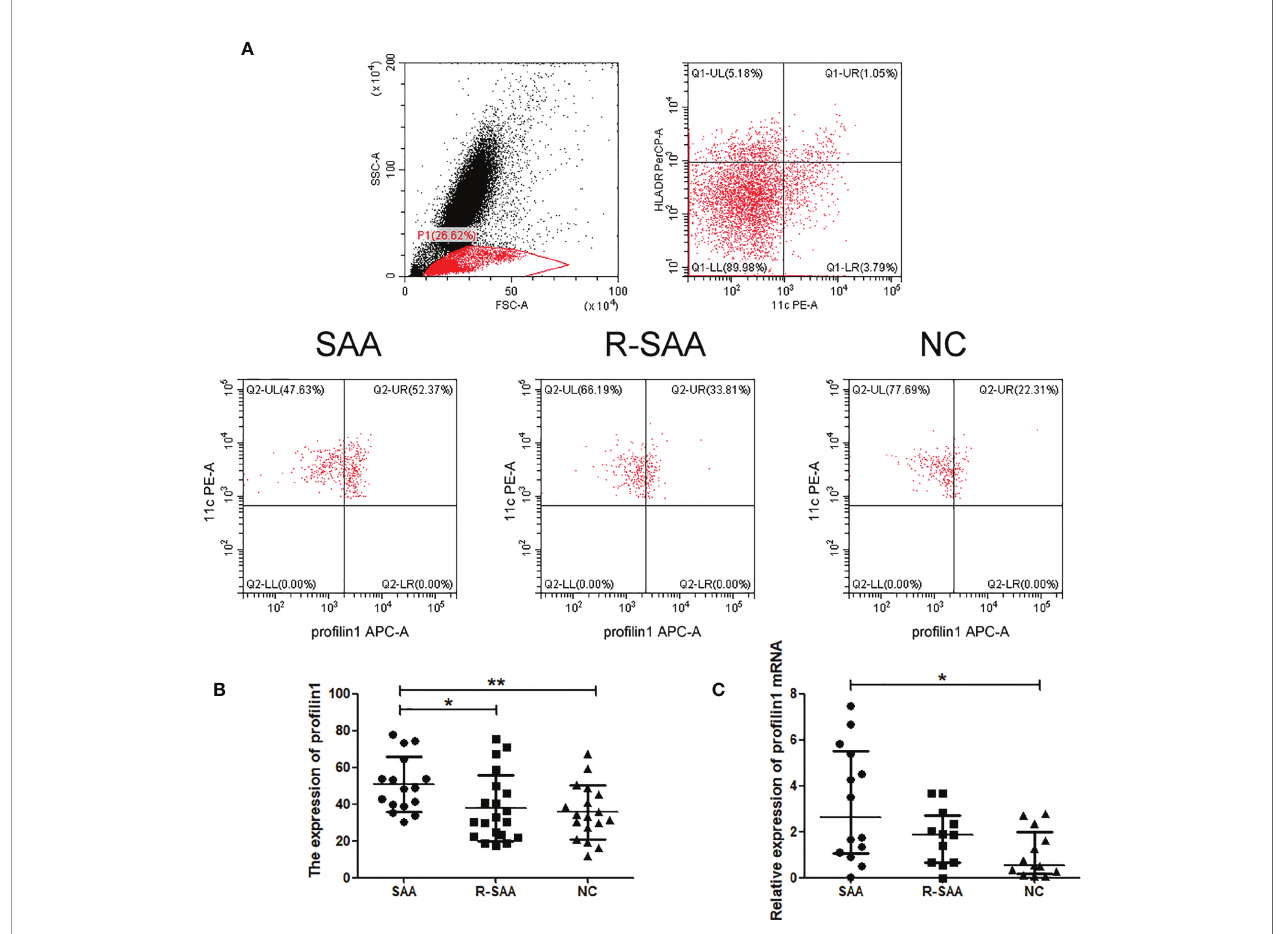
FIGURE 1 | The expression of pro fi lin 1 on mDCs in SAA patients and normal controls (A) Expression assessed using fl ow cytometry. (B) Pro fi lin 1 expression on CD11C+ HLA-DR+ cells in patients with SAA and normal controls. (C) Relative expression of pro fi lin1 mRNA in mDCs determined using reverse transcription- quantitative PCR. *p < 0.05, **p <